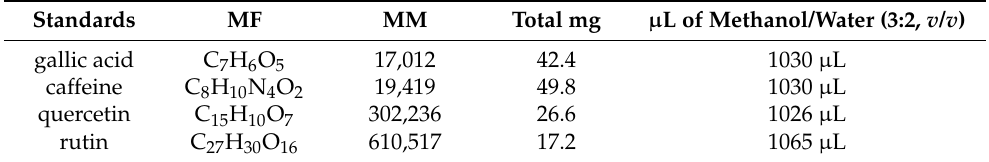
Table 10. Data for preparation of